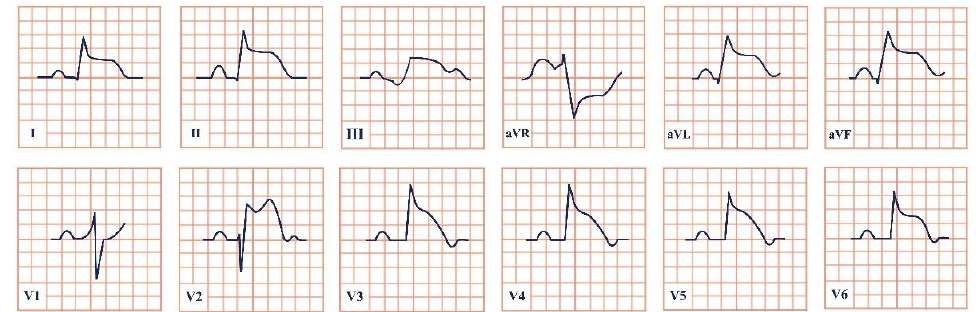
Figure 4. Electrocardiogram aspect in Takotsubo